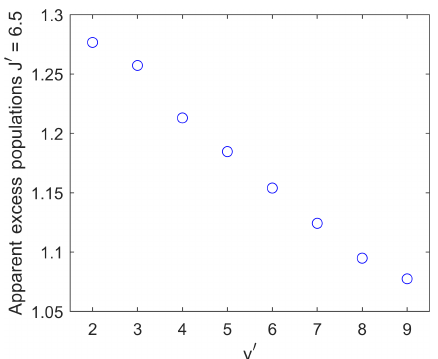
Figure 8. The maximum apparent excess population of the J (cid:48) = 6 . 5 upper level for a wave with wavelength 30km and an amplitude of 30K at 90km altitude as a function of the vibrational upper level. The effect of the waves creating the apparent excess population de- creases with a rising vibrational quantum number v (cid:48)